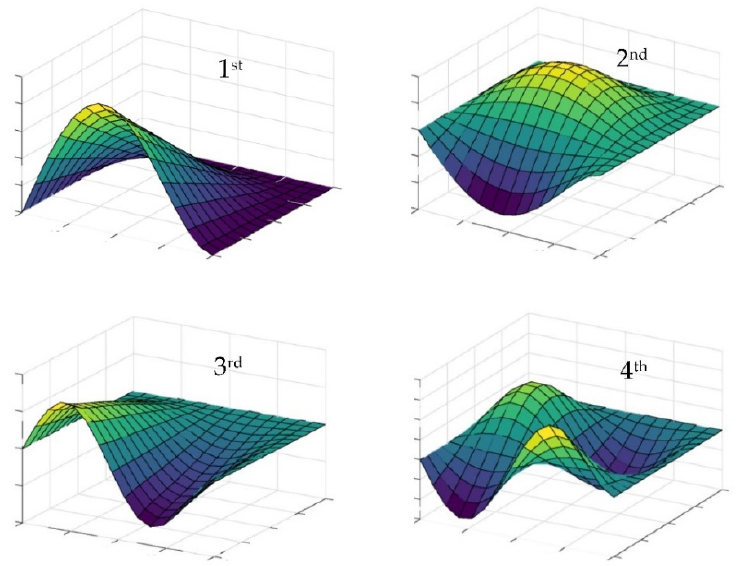
Figure 10. Diagrams of the first four modes of undamped vibrations for the plate mounted according to Figure 3b.